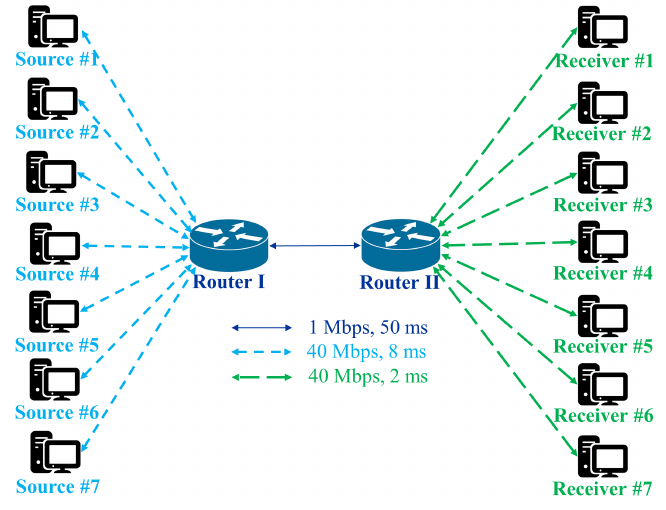
Figure 4. The simulation setup. Table 1. Simulation